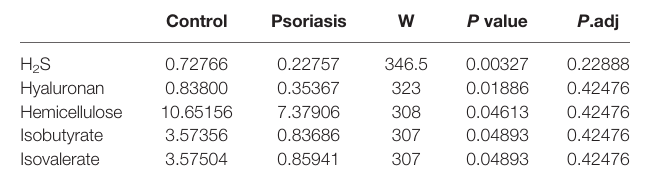
TABLE 3A | Upregulated KEGG pathways in psoriasis patients versus healthy subjects.